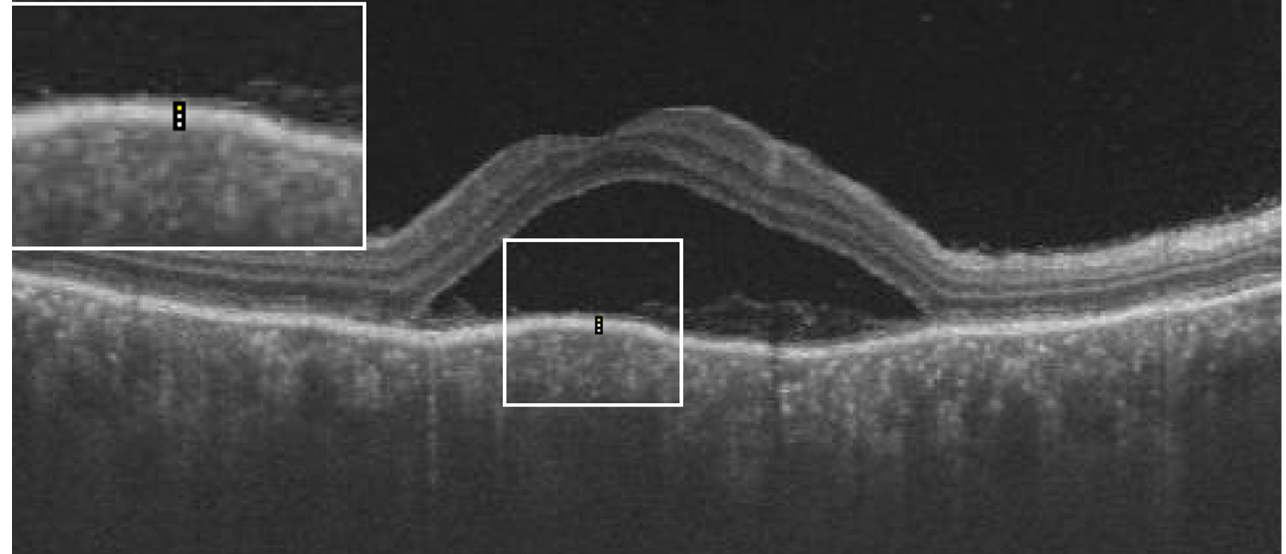
Figure 2. Example showing measurement of retinal pigment epithelial (RPE) thickness (white dotted line in the white box inset at the top left corner) using ImageJ software. Subretinal hyperre fl ective dots were de fi ned as hyperre fl ective dots below the neu- roidal hyperre fl ective dots were de fi ned as circumscribed dots within the choroid seen on an OCT scan having equal or higher re fl ectivity than the RPE band (Figure 4). Bacillary layer detachment was de fi ned as a split of the neurosensory retina at the level of the myoid zone in the photoreceptor layer (Figure 4). RPE vacuolations were de fi ned as hypo re fl ec- tive cavities within the RPE (Figure 3A).